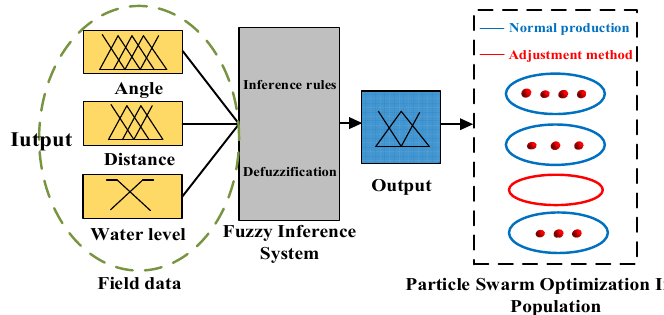
Figure 12. Combination of domain knowledge and PSO. The evolution algorithm is used to optimize the allocation scheme after the population is generated. The process of solving ballast water dynamic allocation scheme by FPSO algorithm is shown in Figure 13.